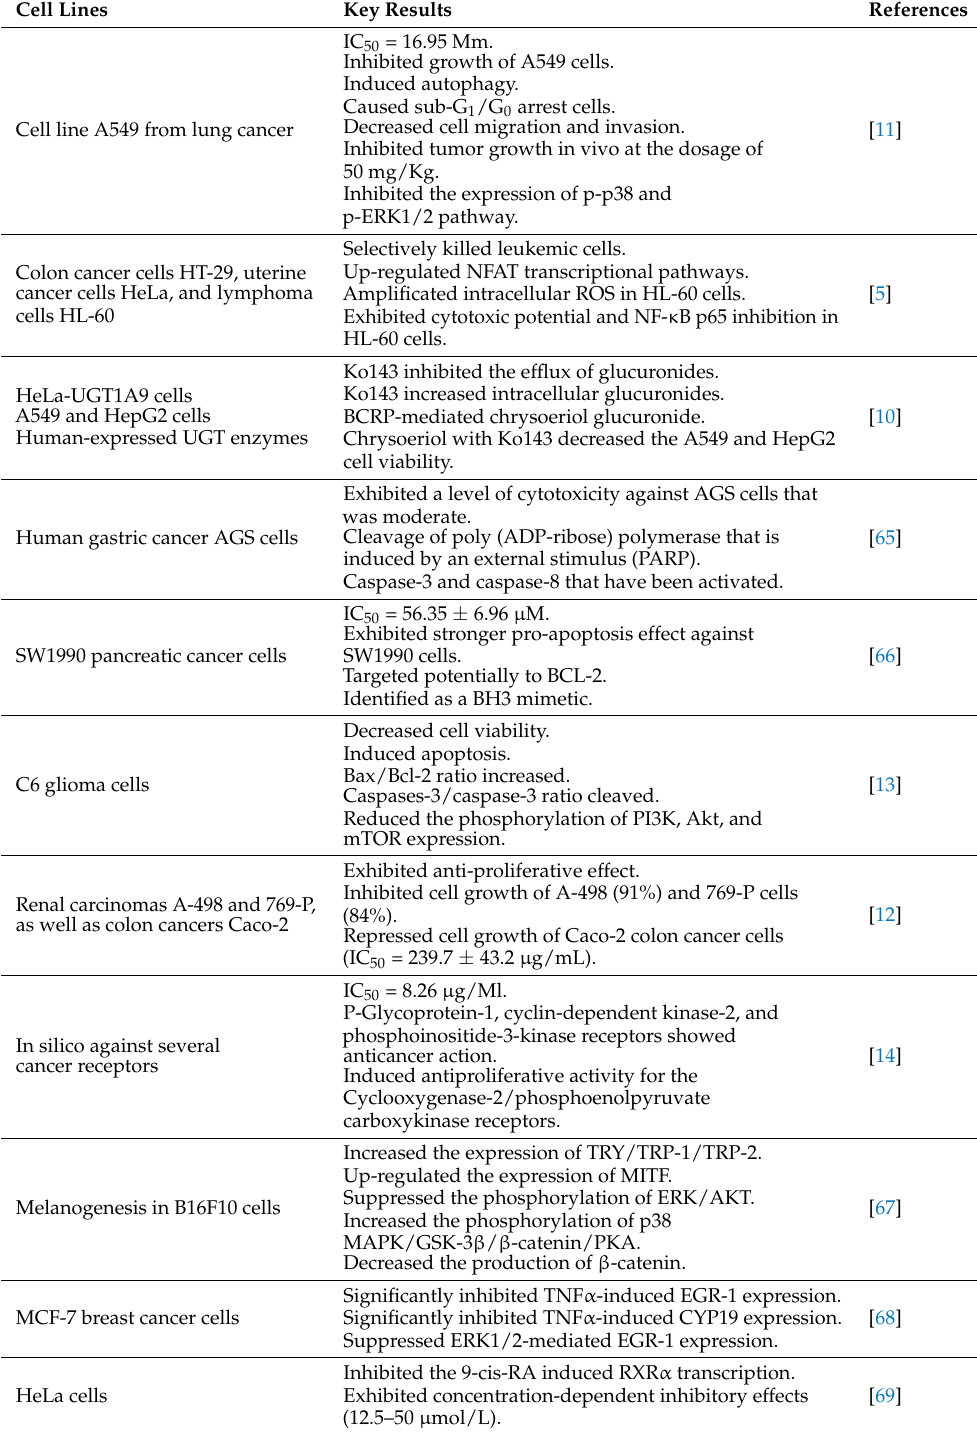
Table 2. Anticancer effects of